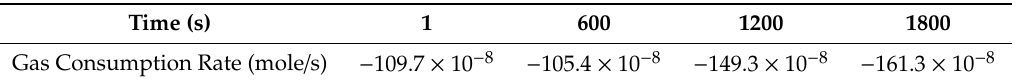
Table 1. Gas consumption rates of experiment